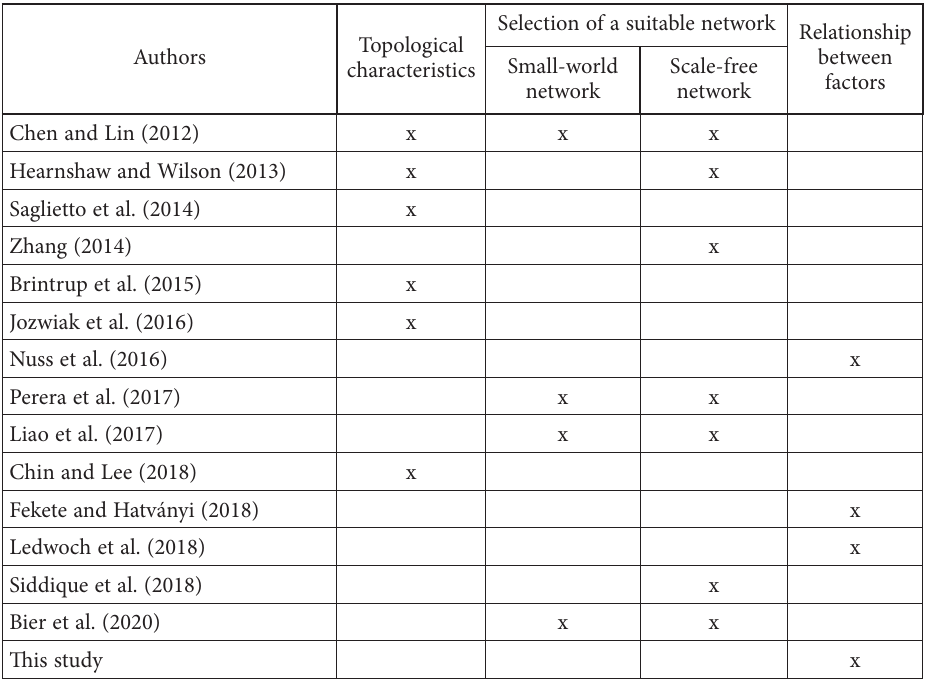
Table 1. Relevant problems for applying network science in previous studies (source: authors’ own